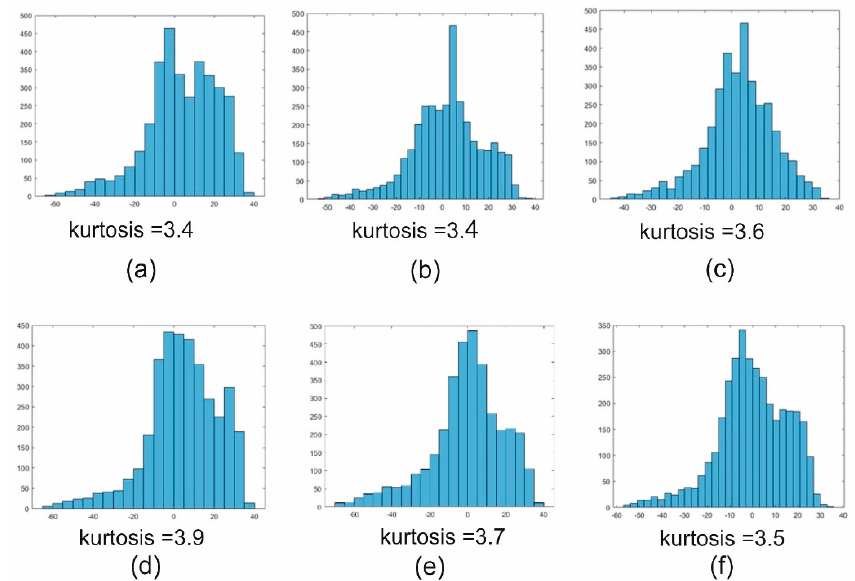
Figure 7. ( a – f ) Distribution of differences 𝑑 (cid:3038) − 𝑑 (cid:3036)(cid:3037) in six sample blocks.